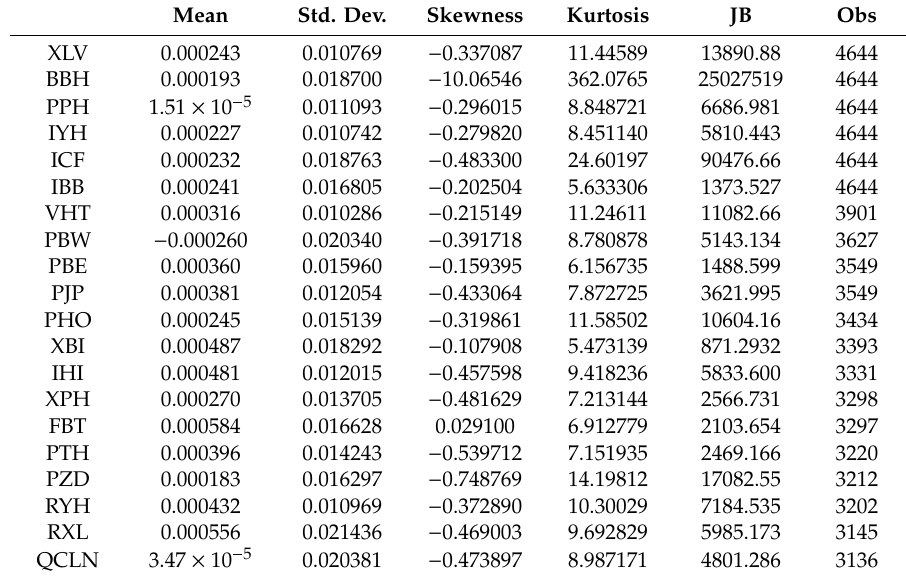
Table 3. Descriptive statistics social responsible